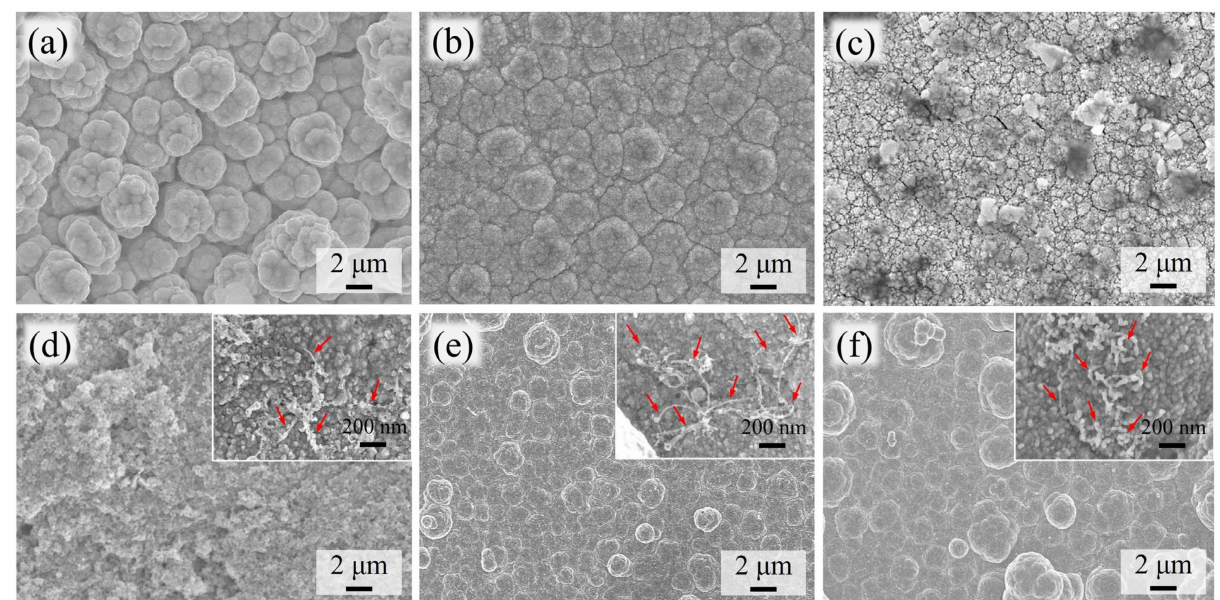
Figure 6. Surface SEM images for Cu ( a – c ) and Cu/CNT platings ( d – f ) deposited at a current density of ( a , d ) − 3 mA/cm 2 , ( b , e ) − 7 mA/cm 2 , and ( c , f ) − 10 mA/cm 2 . Inset images in ( d – f ) show respective high-magnification images and red arrows indicate codeposited CNTs.